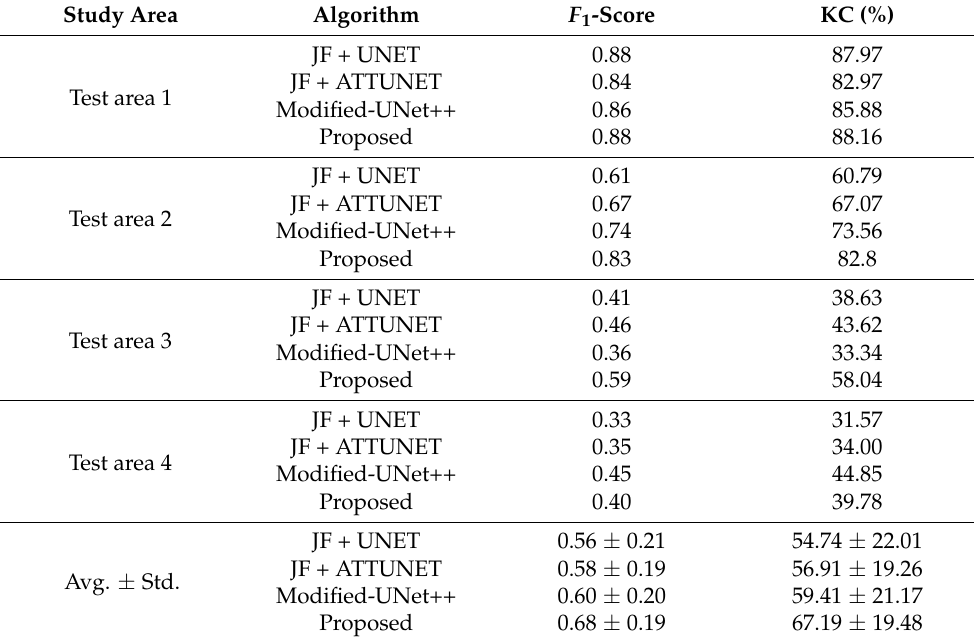
Table 5. F 1 -score and KC with reverse image order for the data-augmented KOMPSAT-3 dataset.